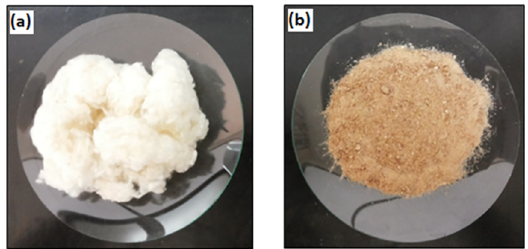
Figure 1: Cotton linter (a) and nanolinter (b) as used to make PCL